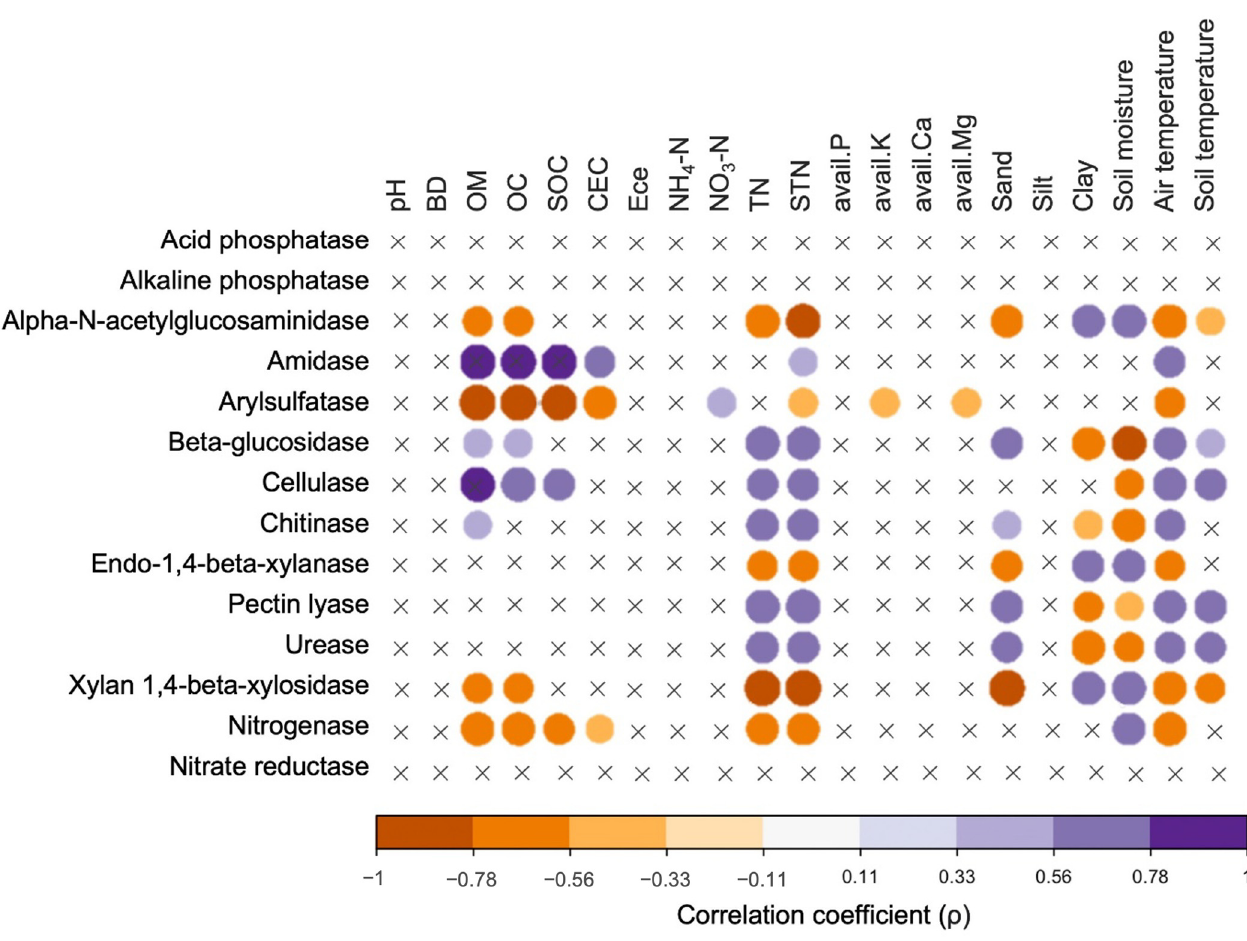
Figure 8 . Spearman ’ s rank correlation between soil properties and soil enzymes predicted with PICRUSt2 . X marks indicate insignificant correlation, whereas circles indicate a significant correlation ( p < 0 . 05 ). Circle color corresponds to the correlation coefficient .